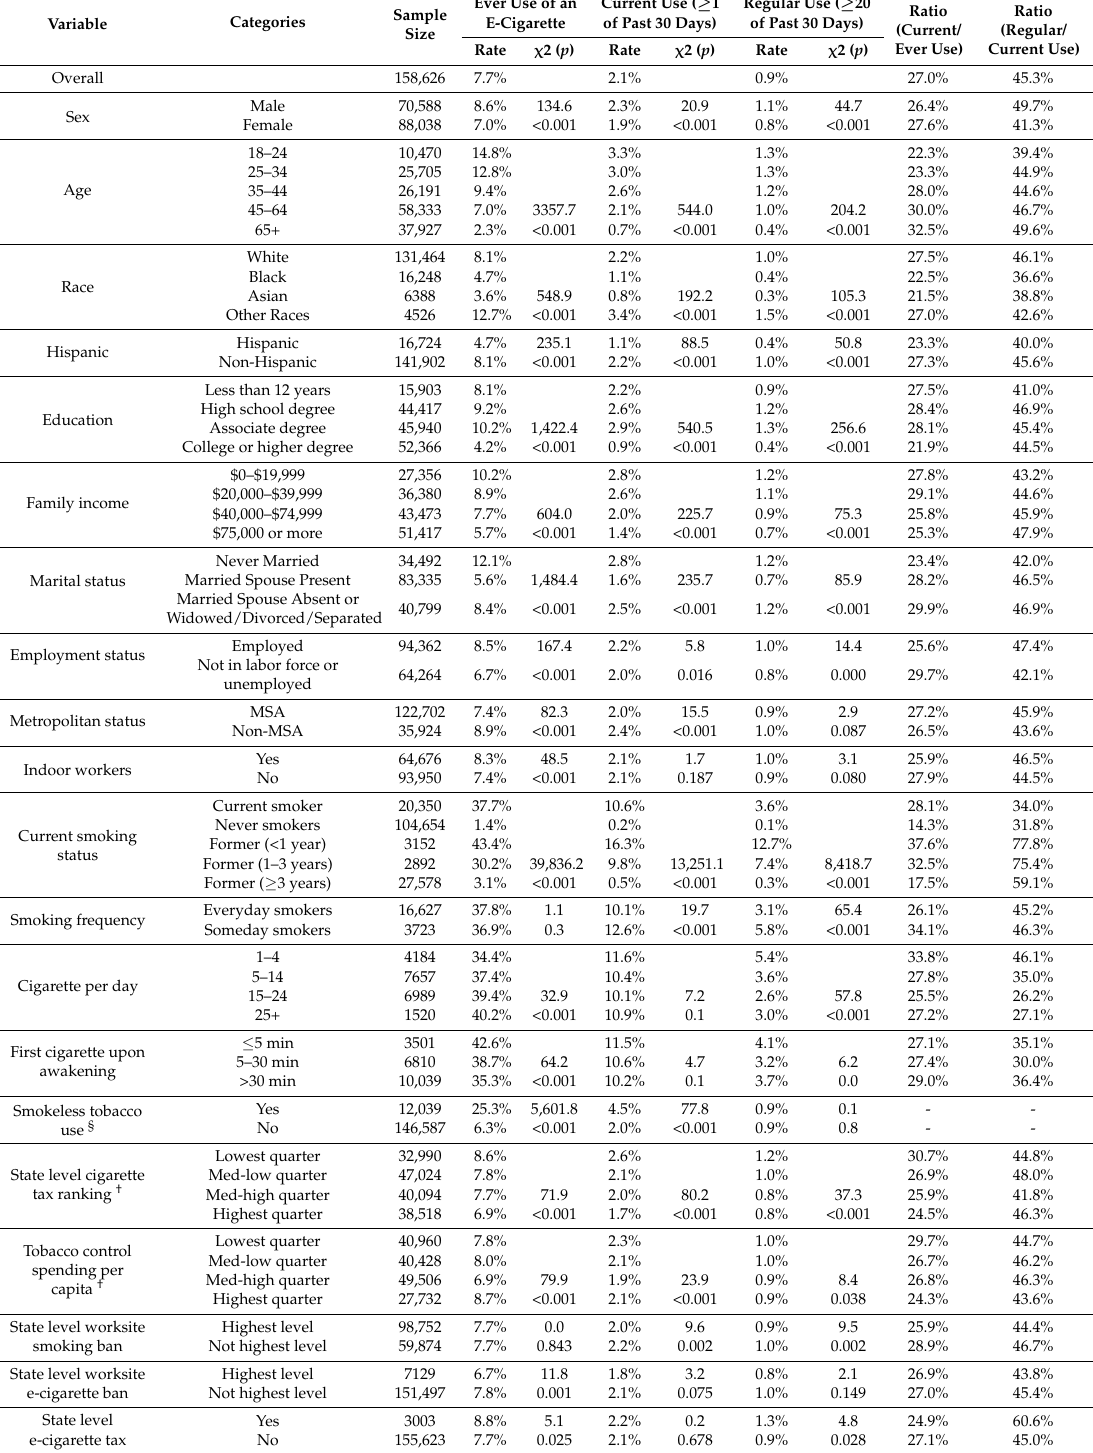
Table 1. Ever, current and regular measures of e-cigarette use, total population, CPS-TUS,